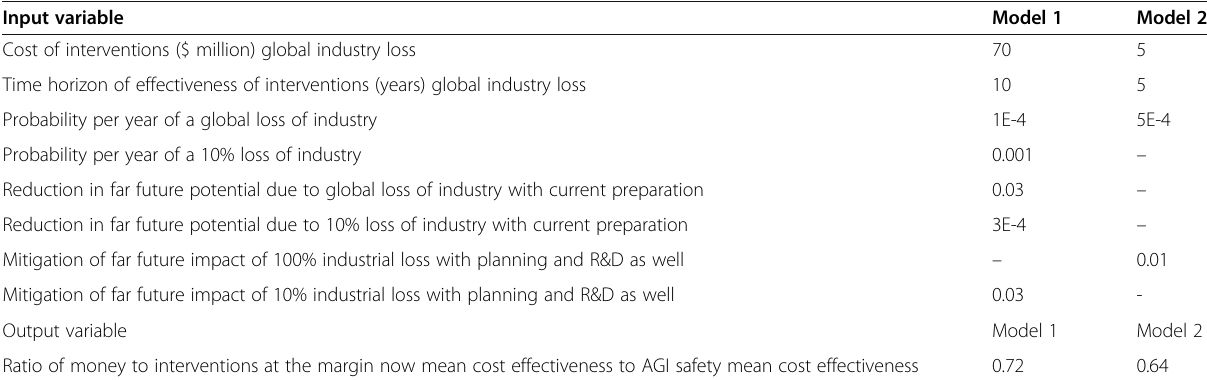
Table 4 Combination of input variables resulting in AGI safety being more cost effective than losing industry interventions at the margin